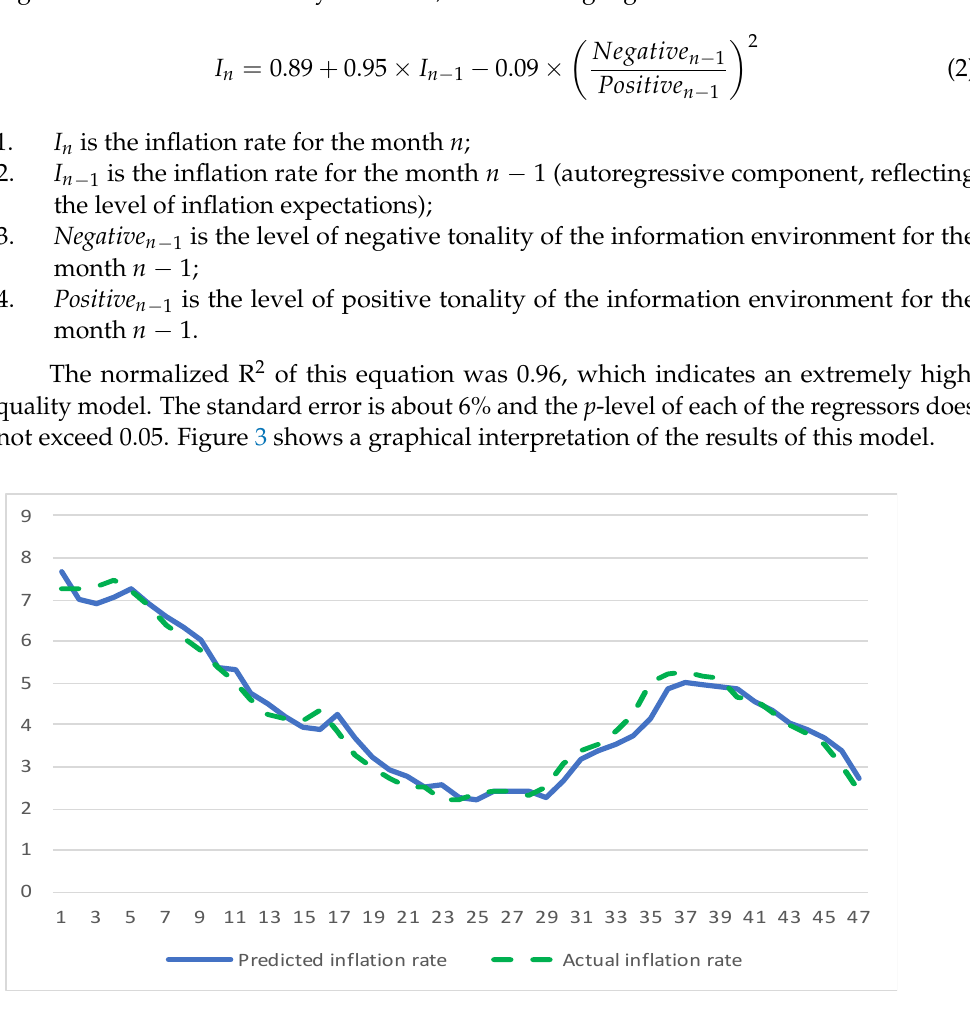
Figure 3. Dynamics of the actual and predicted inflation rate. Source: developed by the authors. As can be seen in the graph, there are no significant structural gaps and outliers, which indicates a high-quality approximation. The form of the regressor reflecting the influence of the tonality of the information environment is determined empirically (the decreasing p-level was the selection criterion), hence it can be argued that, in terms of influencing the external information capital of the enterprise, the tonality of the infor- mation environment is determined by the square of the ratio of the negative and positive tonal component. At the same time, the impact of this index on inflation is negative. This fact fully confirms the hypothesis that, with an increase in the negative tonal component, an individual tends to reduce his level of consumption and increase his savings. The in- fluence of this index on the index of external information capital can be considered as reciprocal. Therefore, the tonality index of the information environment ( I t ) is calculated as follows: (cid:1835) (cid:3047) = −(cid:3436) (cid:1840)(cid:1857)(cid:1859)(cid:1853)(cid:1872)(cid:1861)(cid:1874)(cid:1857) (cid:1842)(cid:1867)(cid:1871)(cid:1861)(cid:1872)(cid:1861)(cid:1874)(cid:1857) (cid:3440) (cid:2870)